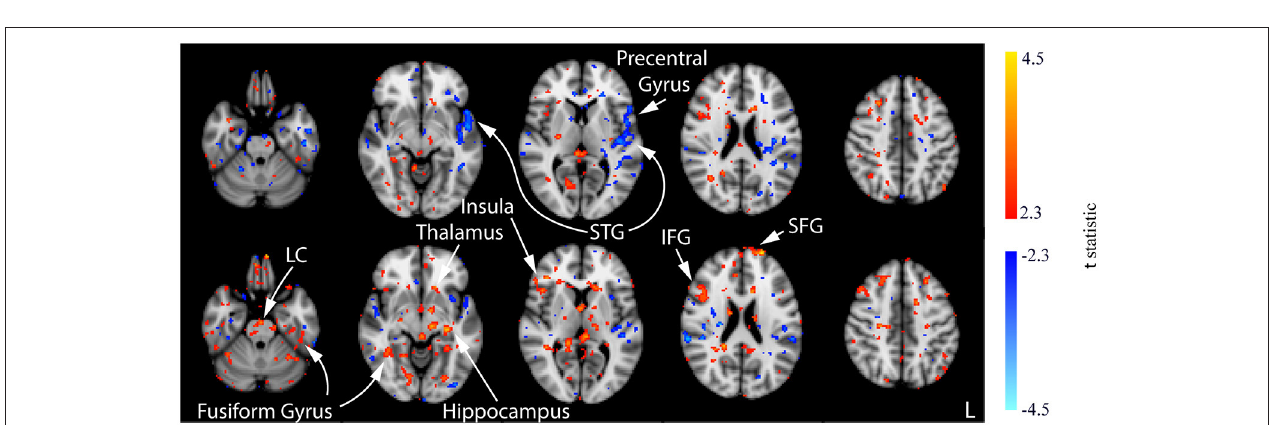
FIGURE 9 | Results of the one-way ANOVA for the ACT 2mA group displayed through post-hoc , pairwise comparisons between session 1 pre-stimulation and session 2 post-stimulation (top row) and session 3 post-stimulation (bottom row). Corresponding images demonstrating the magnitude of CBF changes are given in Supplementary Figure 5 . Axial slices are taken from MNI coordinates z = − 26, − 8, 6, 22, and 44mm (left to